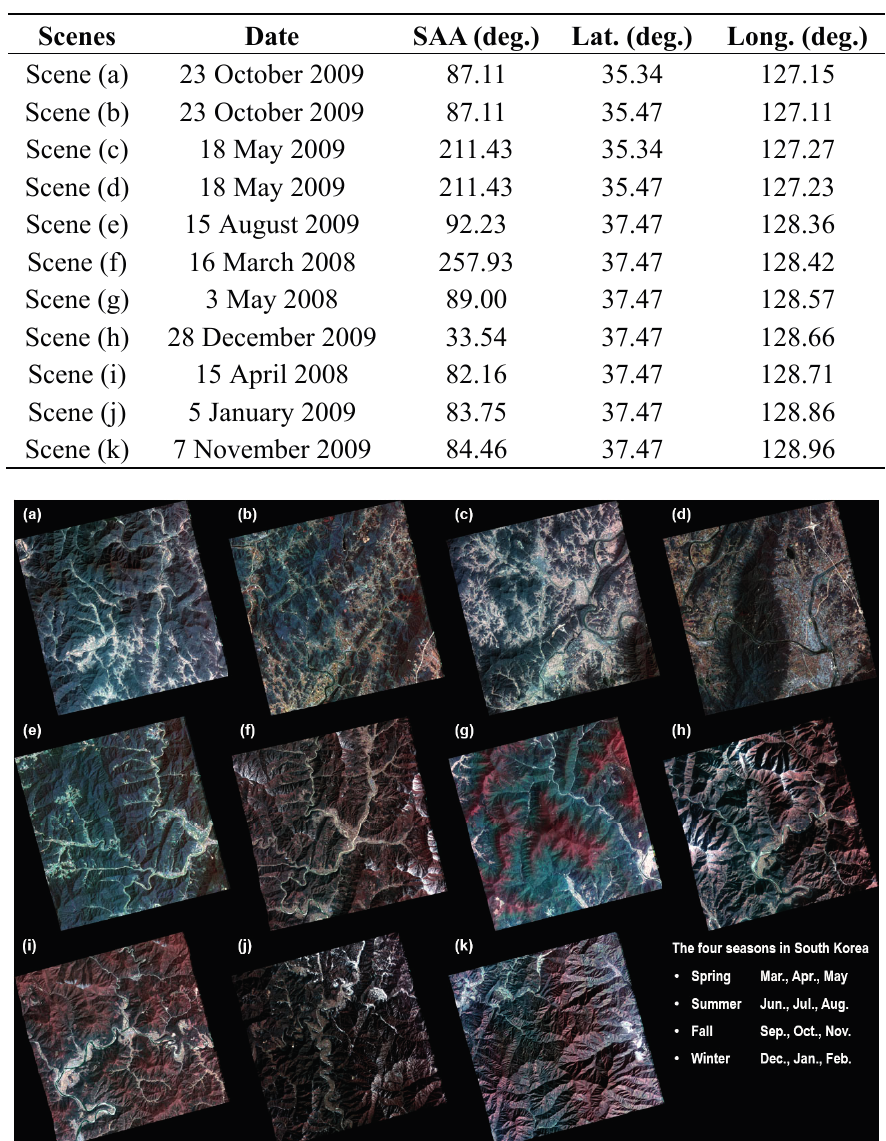
Table 2. Characteristics of the tested Kompsat-2 images.